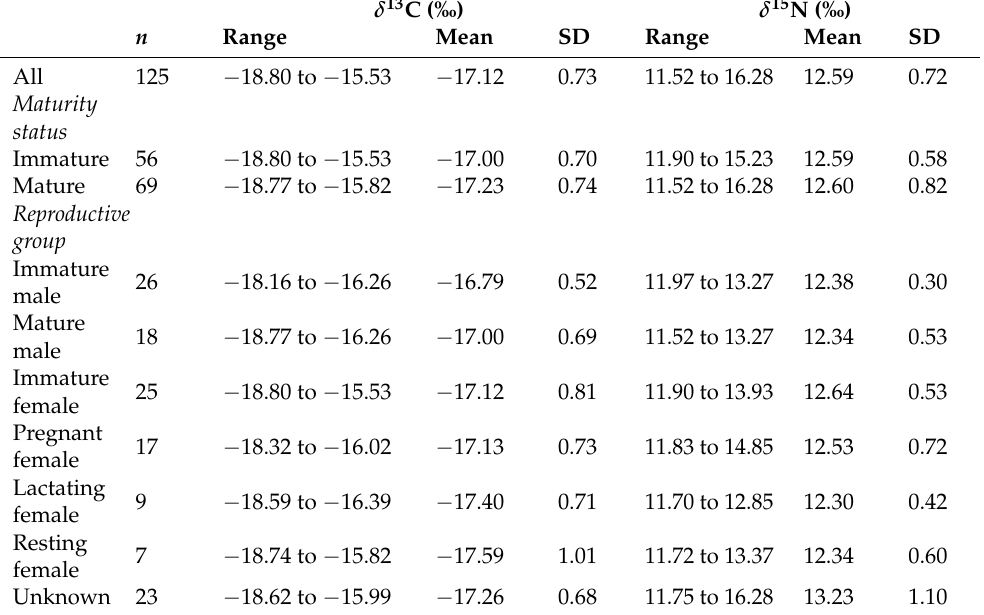
Table 2. Range, mean and standard deviations ( ± 1 SD) of carbon and nitrogen ( δ 13 C and δ 15 N) values of long-finned pilot whales ( Globicephala melas edwardii ) stranded on the New Zealand coast, 2009– 2017, presented by sexual maturity status and reproductive group. Unknown refers to individuals where reproductive group was unable to be determined from reproductive organs, but maturity status was instead classified from body